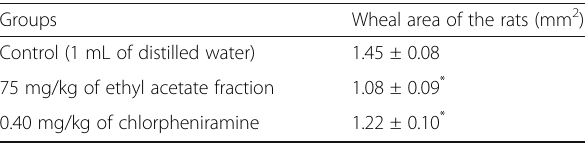
Table 2 Effect of ethyl acetate fraction of Trichosanthes cucumerina Linn on wheal area of the rats